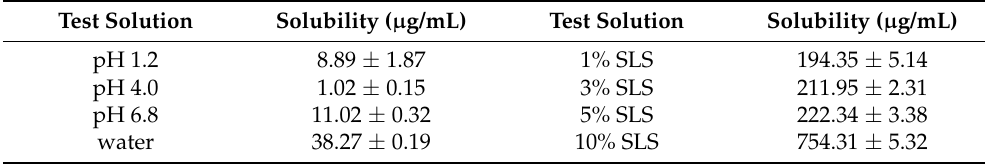
Table 1. Solubility by pH and SLS concentration. All data are expressed as the mean ± SD ( n =